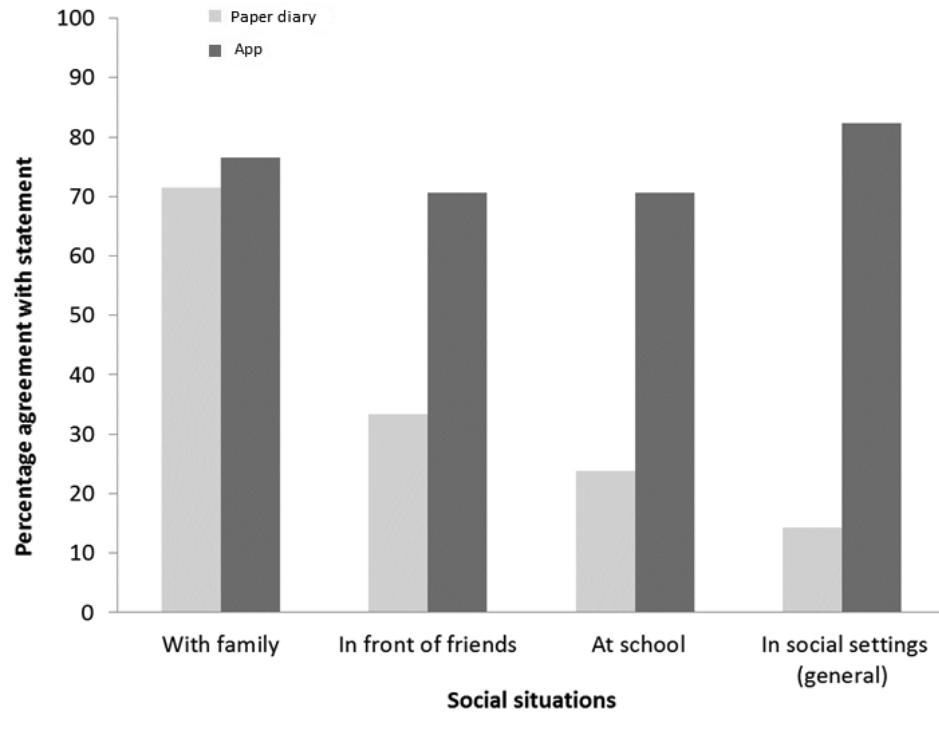
Figure 3. Response to questionnaires in relation to how comfortable participants felt using the paper diary or app in different social scenarios. There is a significant difference between the use of paper diaries and the app in social settings ( P <.001).